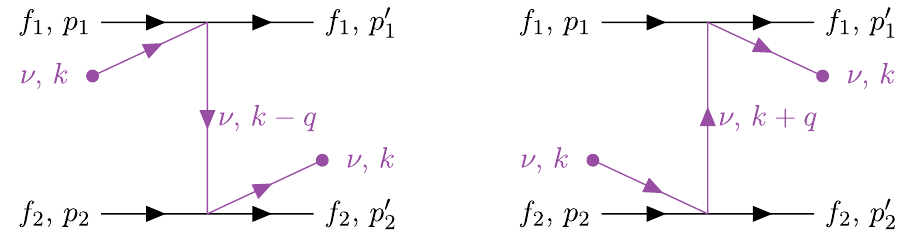
Figure 2. Feynman diagrams contributing to the relevant scattering amplitudes in the presence of a neutrino